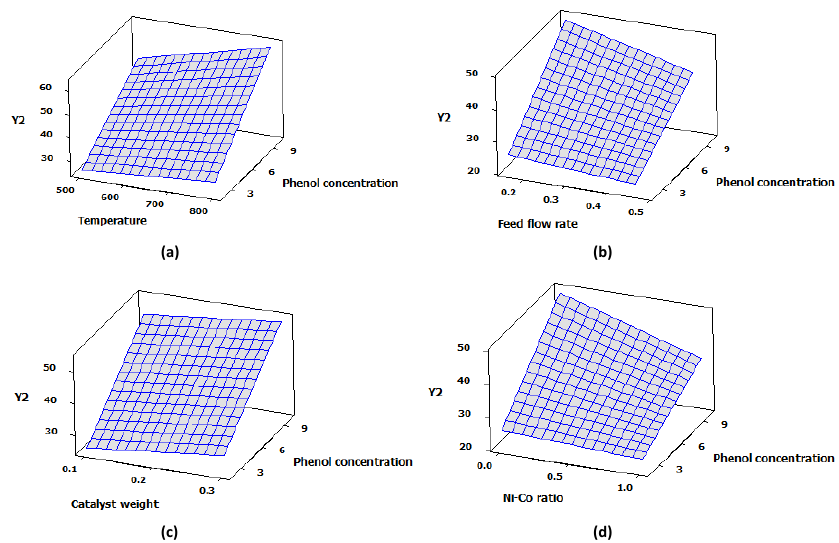
Figure 13. Surface plot for significant interactions on Y 2 : ( a ) AE ; ( b ) BE ; ( c ) CE ; ( d ) DE .